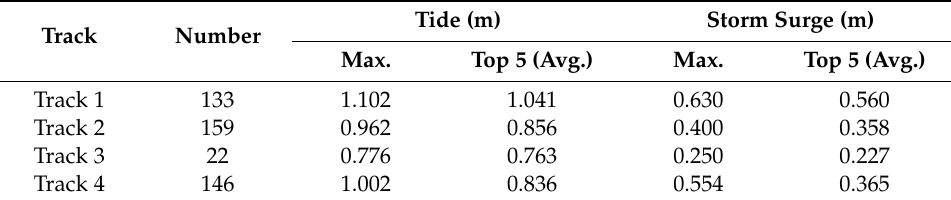
Table 2. The maximum tide and surge of the typhoon from the different track.